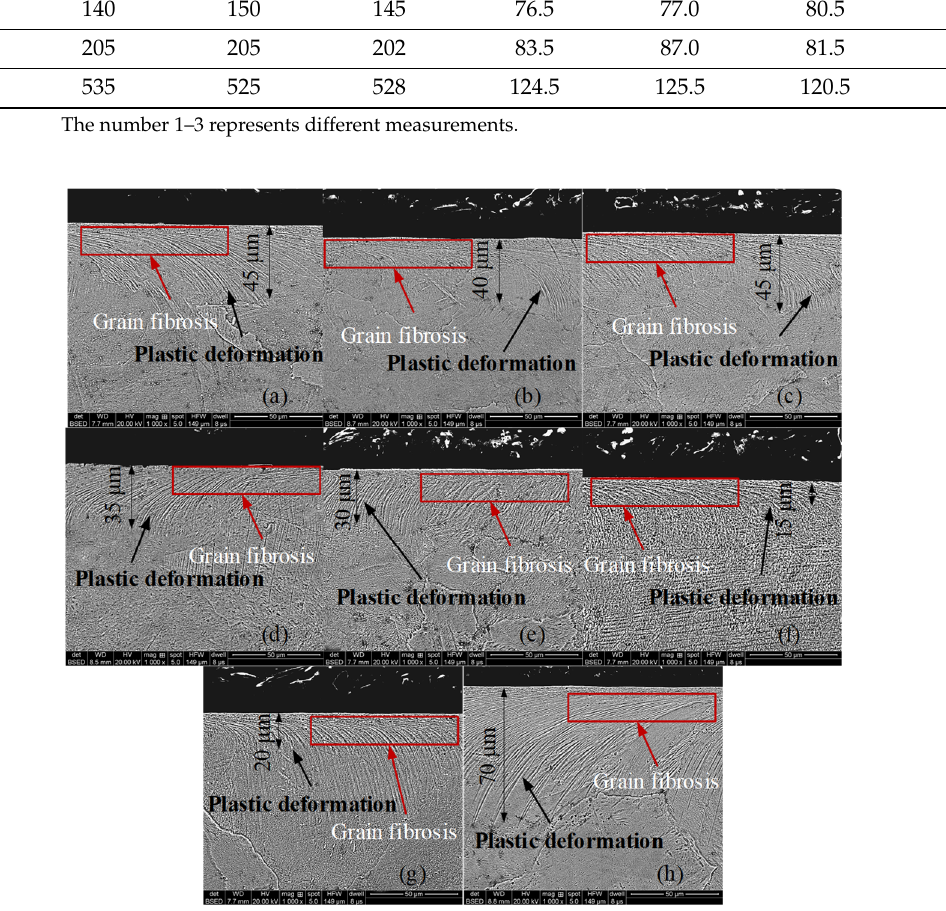
Figure 2. Plastic deformation and grain fibrosis of milling samples: ( a ) 75 m/min, ( b ) 100 m/min, ( c ) 125 m/min, ( d ) 150 m/min, ( e ) 175 m/min, ( f ) 200 m/min, ( g ) 225 m/min and ( h ) 250 m/min.